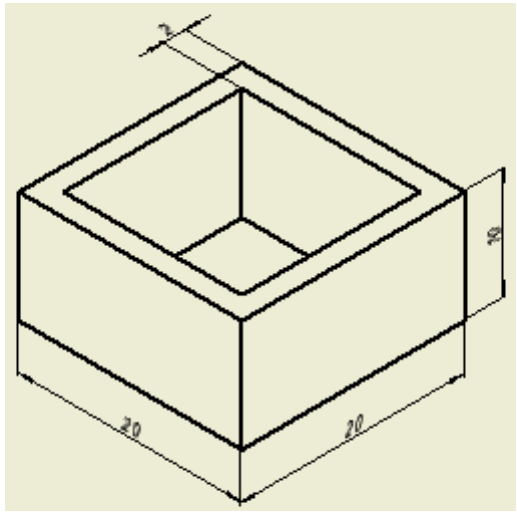
Figure 4. Test model for the 3D printing process using gel-like material.